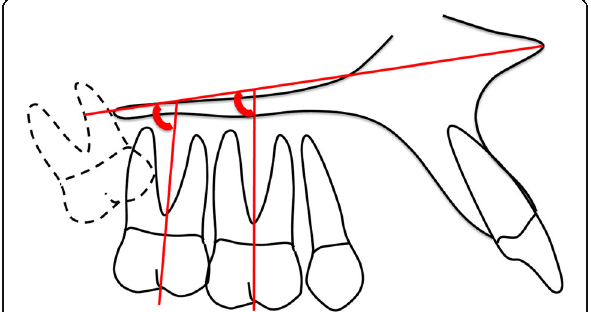
Fig. 4 Evaluation of molar sagittal